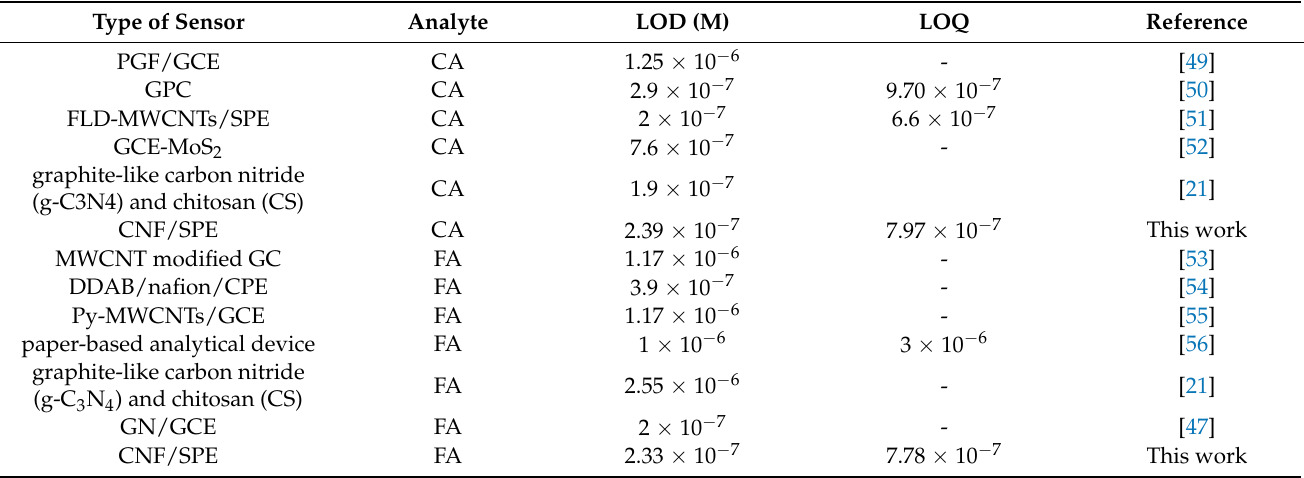
Table 3. Comparison of different methods to determine CA and